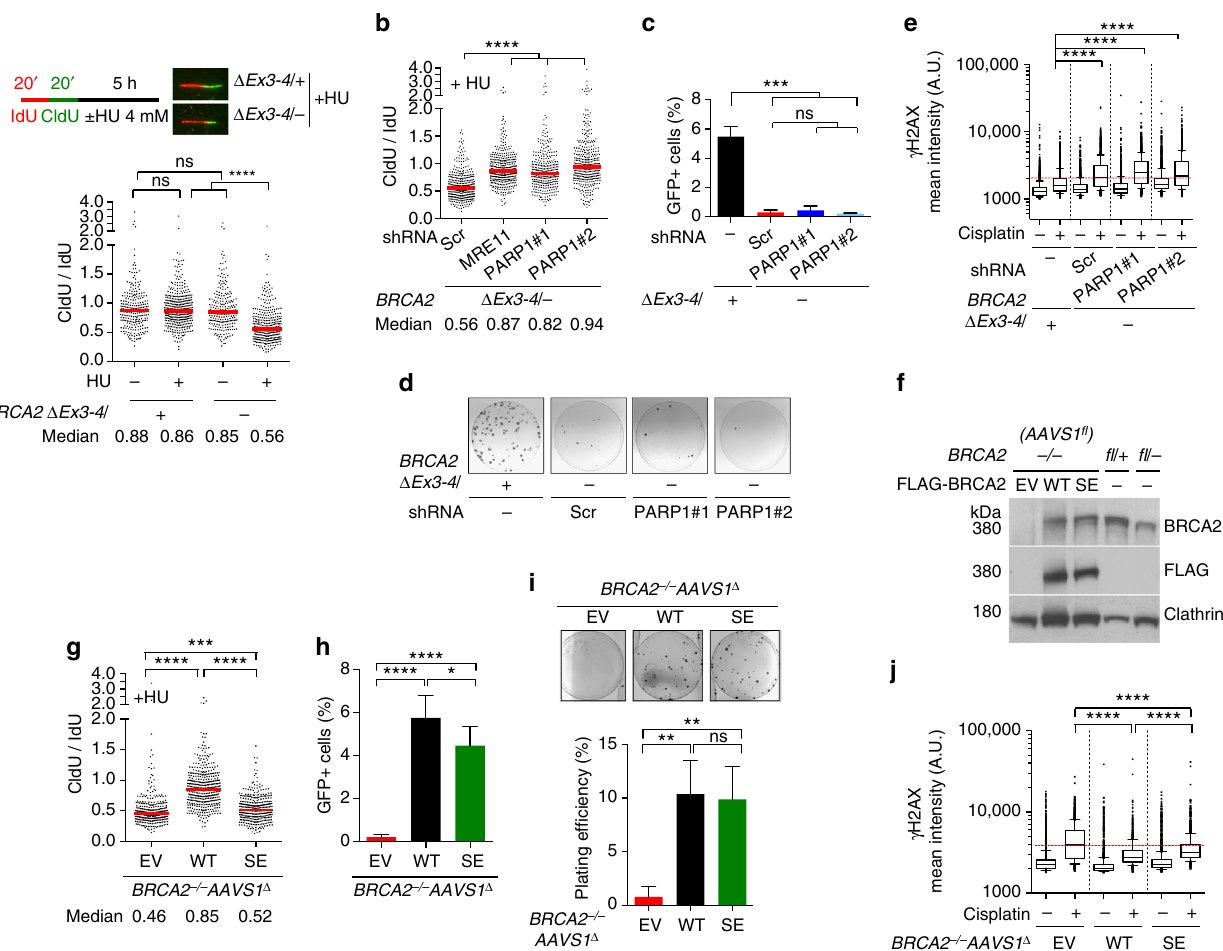
Fig. 2 Fork protection plays a minor role in cell viability and DNA repair. a DNA fi ber analysis to quantify fork protection. Schematic of the experimental design and representative images are shown in the inset . Median CldU/IdU tract length ratios are indicated in the graph ( red bars ). Graphs here and below represent the pooled results of > 200 fi bers per genotype from at least two independent experiments, analyzed by a two-tailed Mann – Whitney test. b Cells stably expressing the indicated shRNAs were analyzed for fork protection in the presence of HU by a two-tailed Mann – Whitney test. Scr, scrambled shRNA. c HR analysis. PARP1 knockdown cells were infected with I-SceI-expressing lentivirus and the percent GFP+ cells was analyzed by an unpaired two- tailed t -test. n = 3. d PARP1 knockdown cells were plated for clonogenic survival. Residual colonies from BRCA2 Δ Ex3-4/ − plates were all were con fi rmed by PCR to have maintained the BRCA2 fl / − genotype (i.e., escaped Cre recombination). e Cisplatin-induced γ H2AX. PARP1 knockdown cells were treated with 5 µ M cisplatin for 5 h and released for another 24 h before analysis. γ H2AX mean nuclear intensities of > 1000 individual cells are shown from one experiment, which is representative of three independent experiments, analyzed by a two-tailed Mann – Whitney test. The dotted red line indicates the median of BRCA2 mutant cells treated with the scrambled shRNA exposed to cisplatin. A.U., arbitrary units. Box and whiskers show the 10th and 90th percentiles. f Western blotting of BRCA2 − / − AAVS1 fl cells stably expressing BRCA2 WT or BRCA2 SE. g DNA fi ber analysis to quantify fork protection in the presence of HU. Median CldU/IdU tract length ratios are indicated ( red bars ), analyzed by a two-tailed Mann – Whitney test. h HR analysis, as in c . n > 3. i Clonogenic survival analysis using an unpaired two-tailed t -test. n = 3. j Cisplatin-induced γ H2AX analysis, as in e . The dotted red line indicates the median of the BRCA2 − / − AAVS1 Δ cells exposed to cisplatin. Error bars s.d. ns, not signi fi cant; * p < 0.05; ** p < 0.01; *** p < 0.001; **** p <